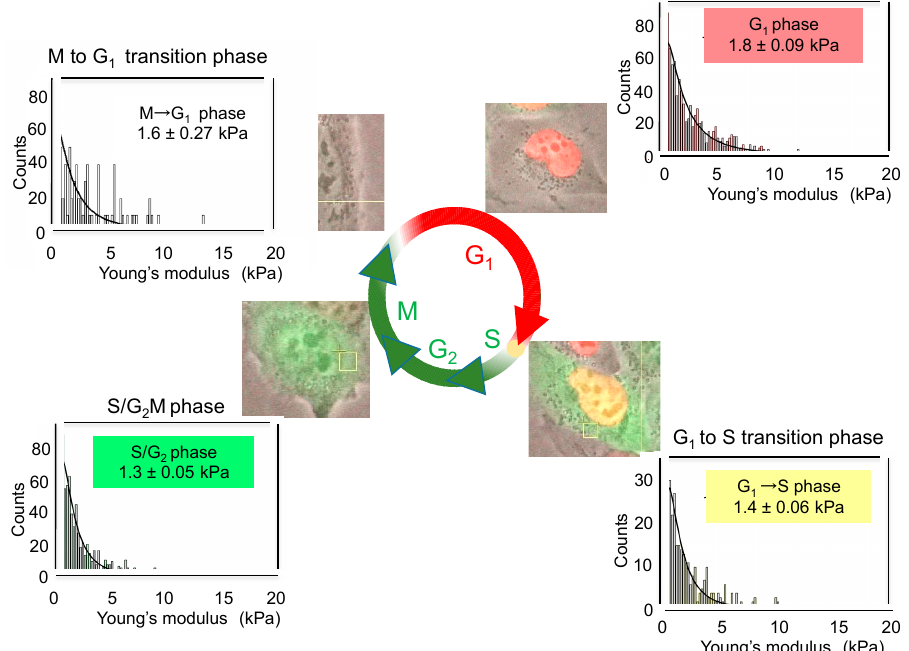
Figure 2. Changes in cell stiffness depending on cell-cycle progression in H1299/Fucci cells. The fluorescent color from red (G 1 phase), to yellow (G 1 to S transition phase), to green (SG 2 /M phase) and to no color (M to G 1 transition phase). Average values of Young’s moduli of cells were determined in each phase by AFM.